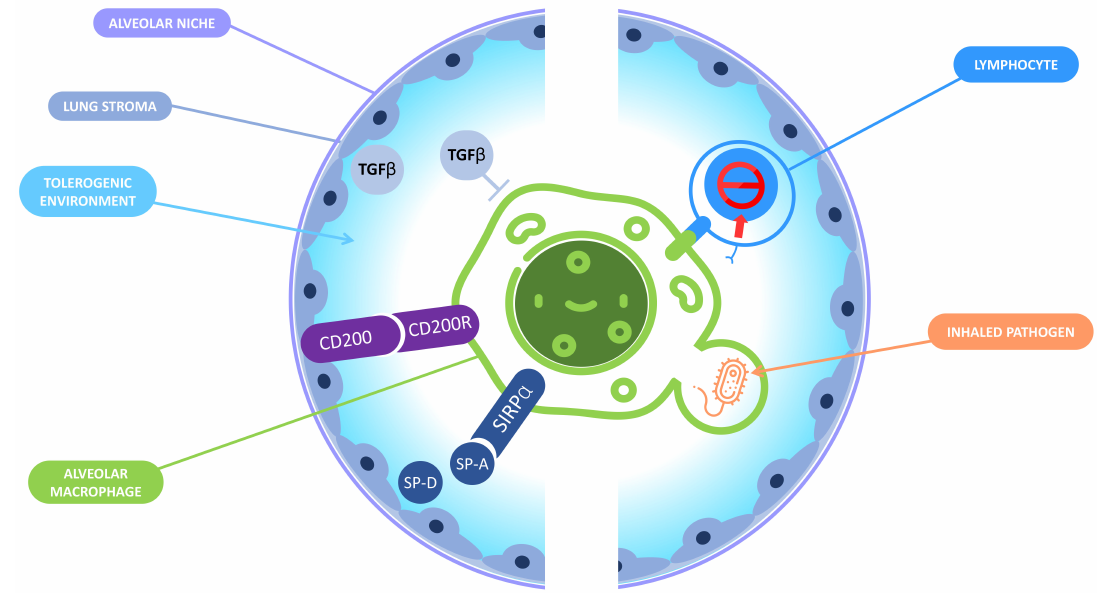
Figure 2. Immune tolerance in the alveolar niche. In the alveolar niche, macrophages and the lung stroma interact together to promote a tolerogenic environment and prevent a deleterious inflammation that could jeopardize the lungs functions. On the one hand, the lung microenvironment induces tolerance in AM: the binding of CD200R expressed by the AM and